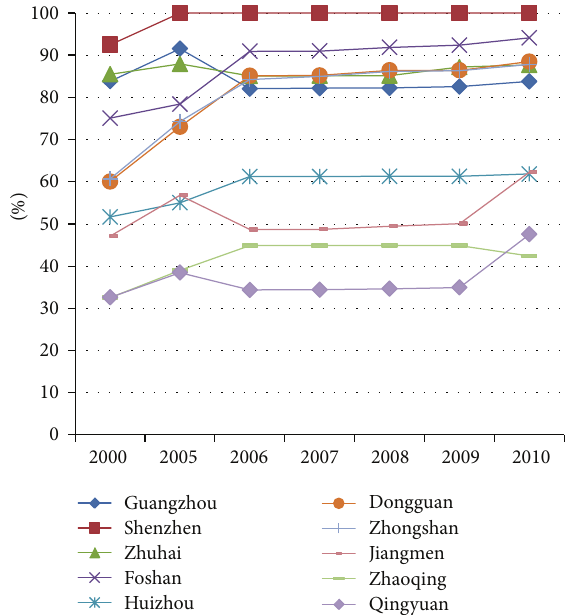
Figure 2: Proportion of urban population to permanent population by city of the PRD. Note: the data in 2000 and 2005 in this figure are calculated according to Interim Regulations on Statistical Clas- sification of Urban and Rural Population issued by National Bureau of Statistics in 1999. The 2006 data are calculated according to Provisional Regulations on Statistical Classification of Urban and Rural Population issued by National Bureau of Statistics in 2006.